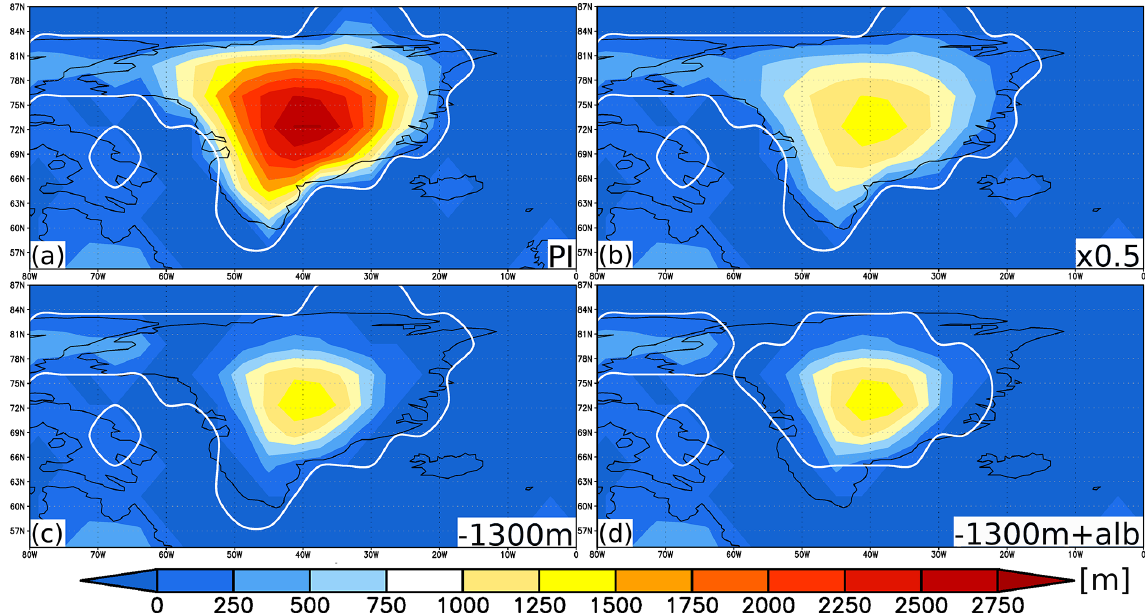
Figure 1. Greenland Ice Sheet (GIS) elevation and land ice cover prescribed in our model simulations: (a) pre-industrial GIS and land ice mask, (b) × 0.5 GIS and pre-industrial land ice mask, (c) − 1300m GIS and pre-industrial land ice mask, and (d) − 1300m and adjusted land ice mask. In (a) , the pre-industrial elevation and land ice mask are unchanged. In (b) , the pre-industrial elevation over the GIS area is multiplied by 0.5; the land ice mask is unchanged. In (c) , for each grid point over the GIS, 1300m is subtracted from pre-industrial elevation; the land ice mask is unchanged. In (d) , for each grid point over the GIS, 1300m is subtracted from pre-industrial elevation; at grid locations where the elevation is lower than 1300m, land ice is removed and albedo is adjusted